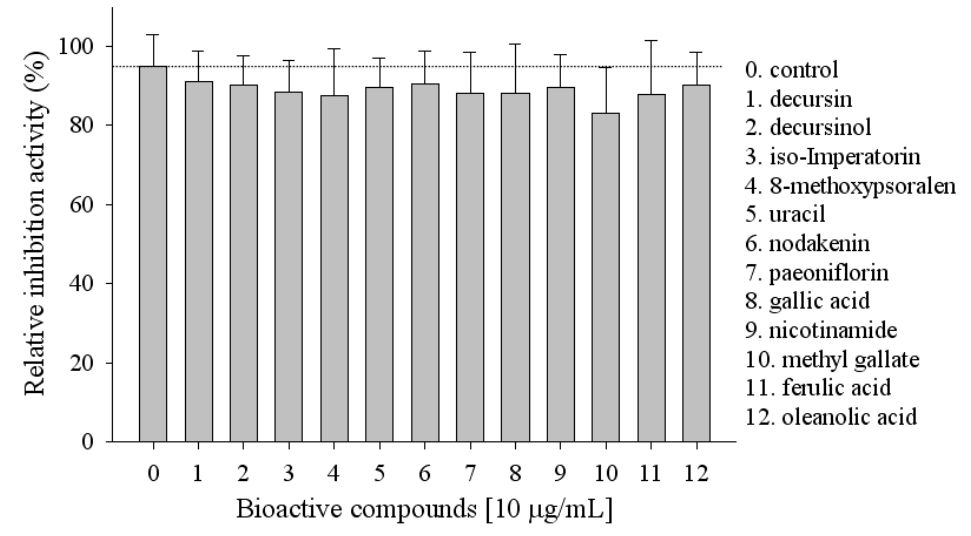
Figure 2. Screening of bioactive compounds with lipid inhibition